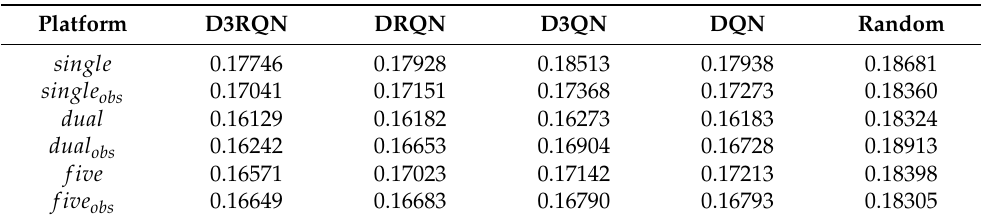
Table 5. Autumn: RMSE comparison of sampling and assimilation results of the observation path between a single platform and multiple platforms.